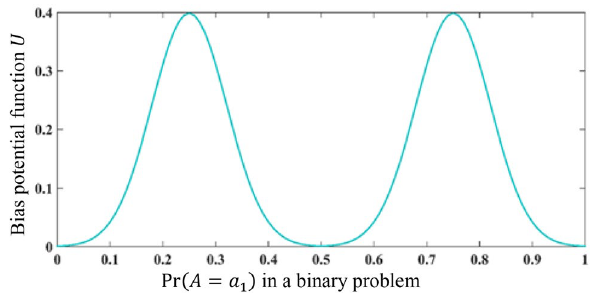
Figure 5. The proposed bias potential function Eq. (21) for modeling biased decision-making. The value of this function is added to the interference term. U (0.5) ≈ 0, due to an unbiased situation in the case of finding equal probabilities in the first node. Also, U (0) = U (1) ≈ 0 because the interference term is removed in certain situations.